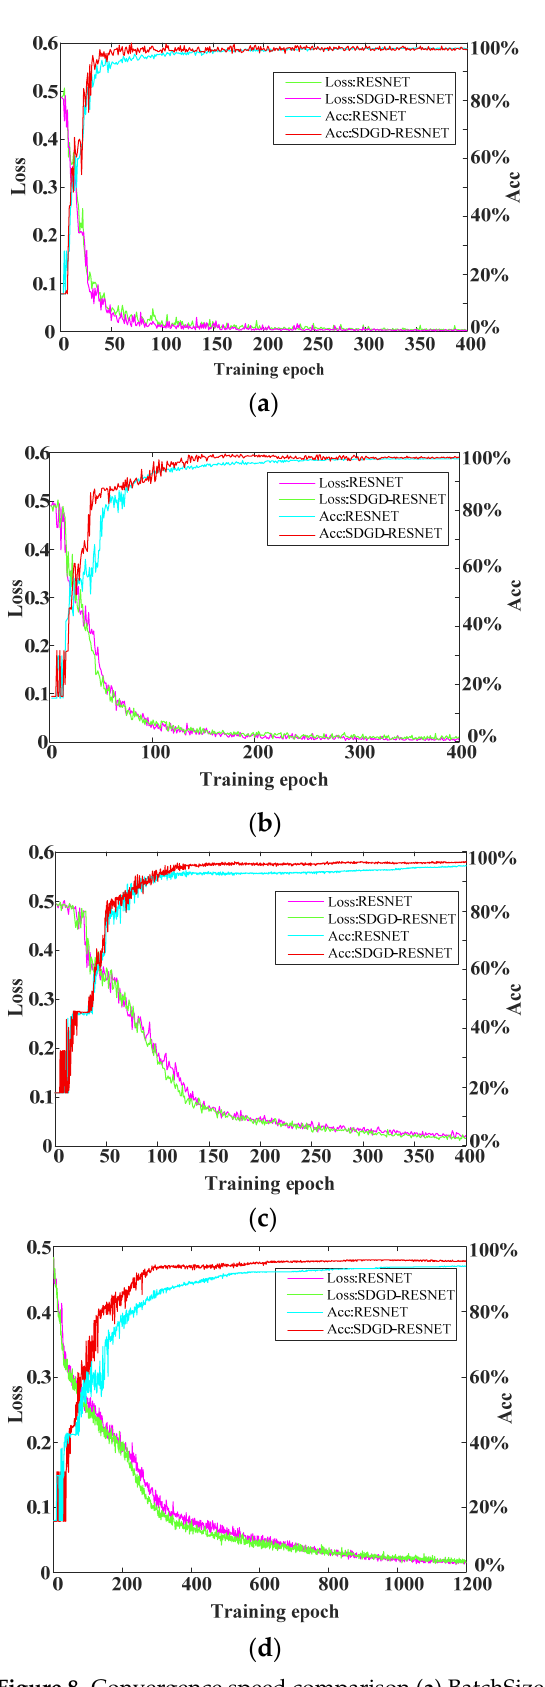
Figure 8. Convergence speed comparison ( a ) BatchSize = 50 ( b ) BatchSize = 100 ( c ) BatchSize = 200 ( d ) BatchSize = 350.